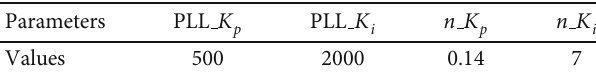
Table 3: PI parameters of 2021 LO [26, 27].